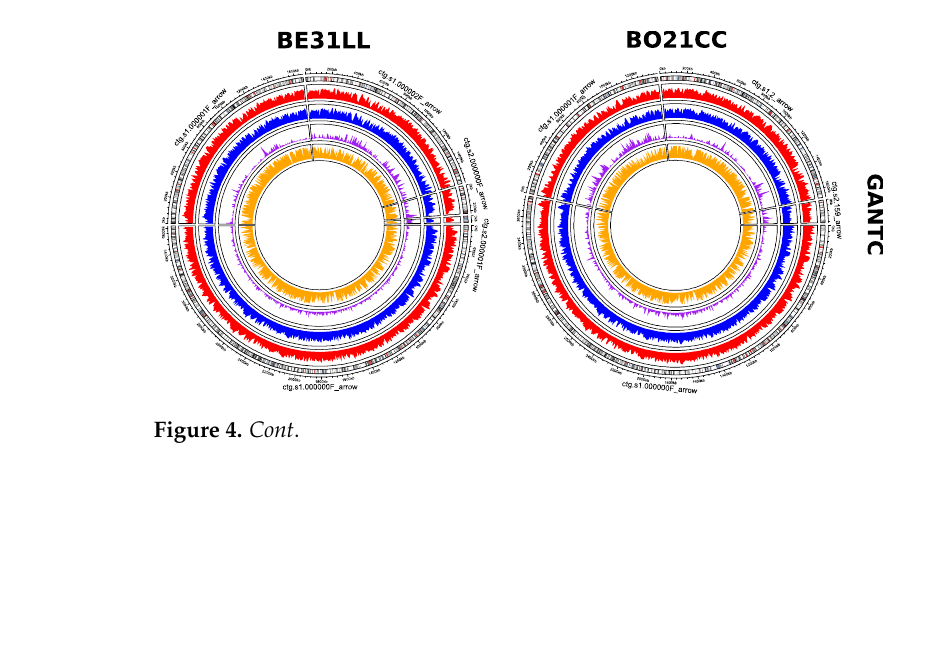
Figure 4. Circular density plots of GANTC and GCCCGGCH motifs in FSM-MA and 1021 strains of S. meliloti . The outer circle represents the genome annotation of the contigs of the strain (black lines indicate the position of CDS). Each inner circle represents a different category of methylated sites, CDS (red), nCDS (blue), tIG (purple), and US (yellow). The bars of each plot indicate the values for each category.